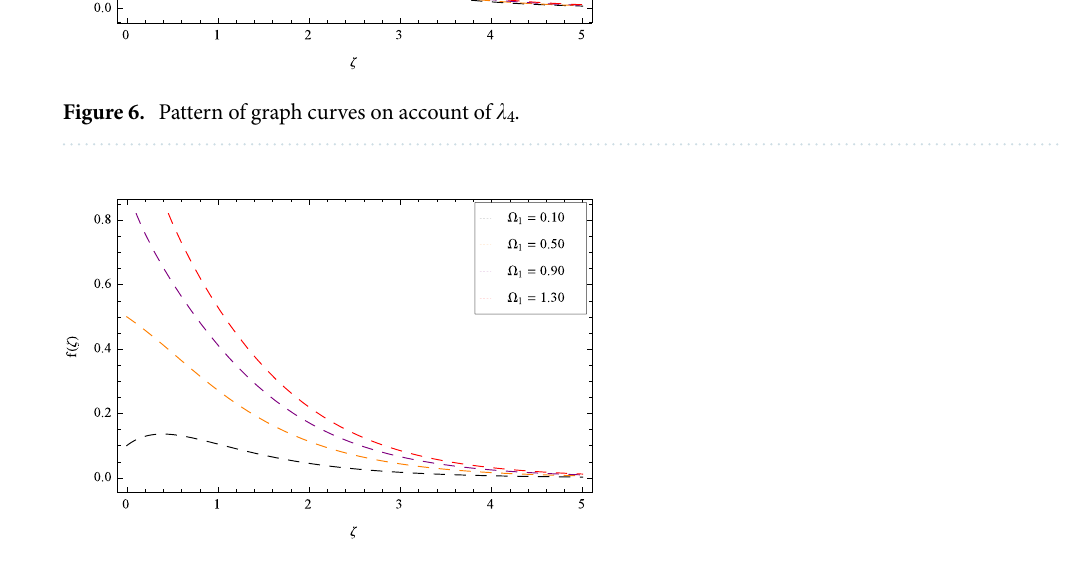
Figure 7. Pattern of graph curves on account of (cid:31) 1